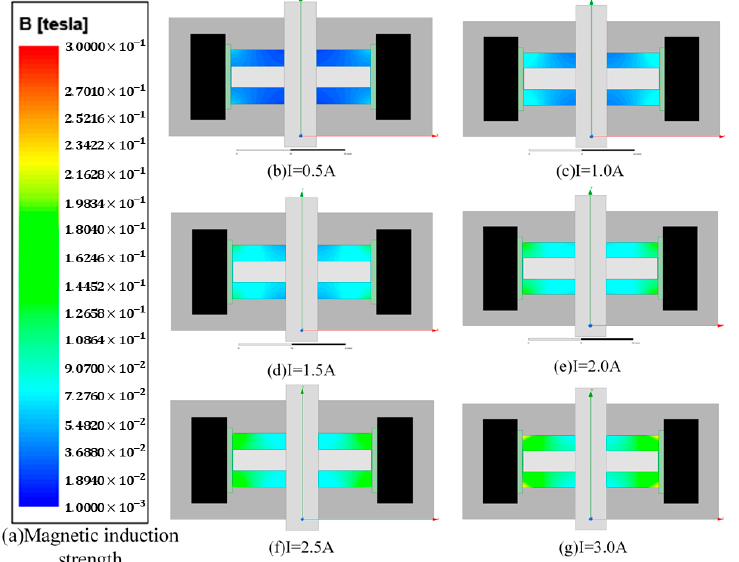
Figure 7. ANSYS MAXWELL simulation results.